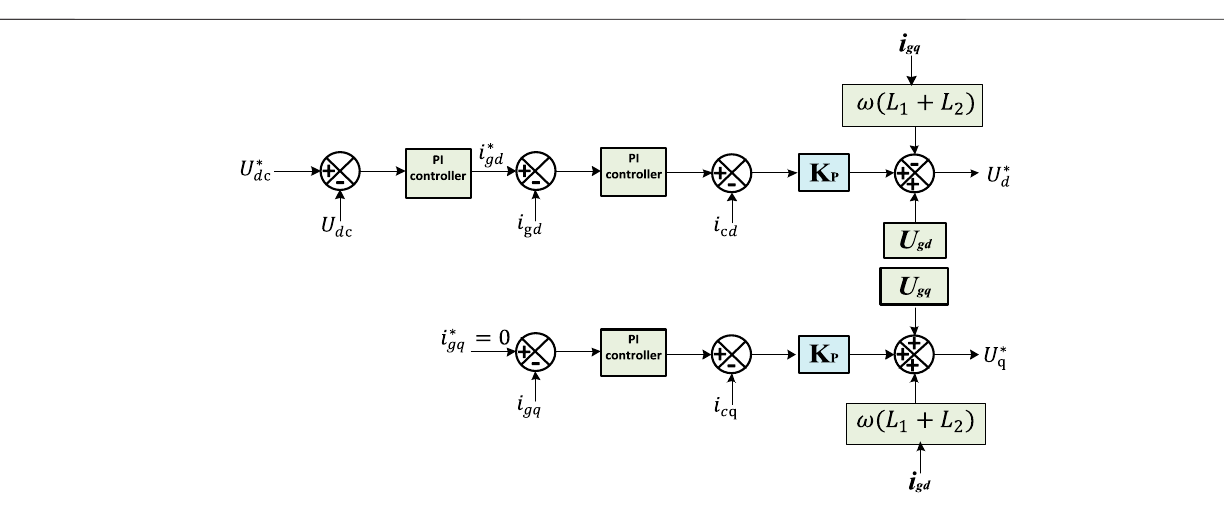
FIGURE 11 | Optimal placement of the SC connected HPGS under weak grid.